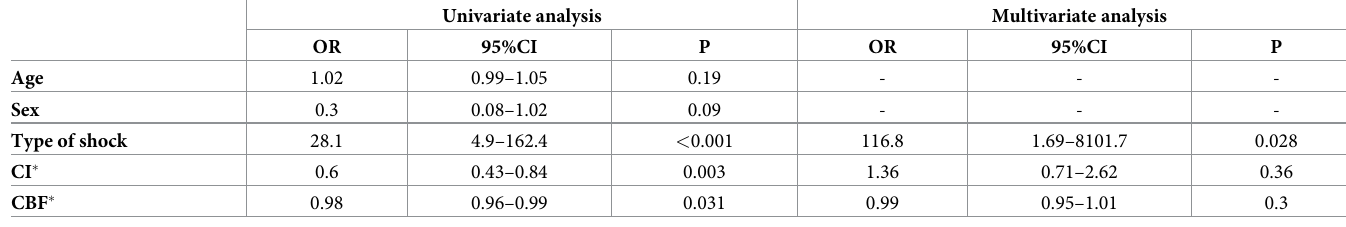
Table 3. Predictors of mortality in the studied